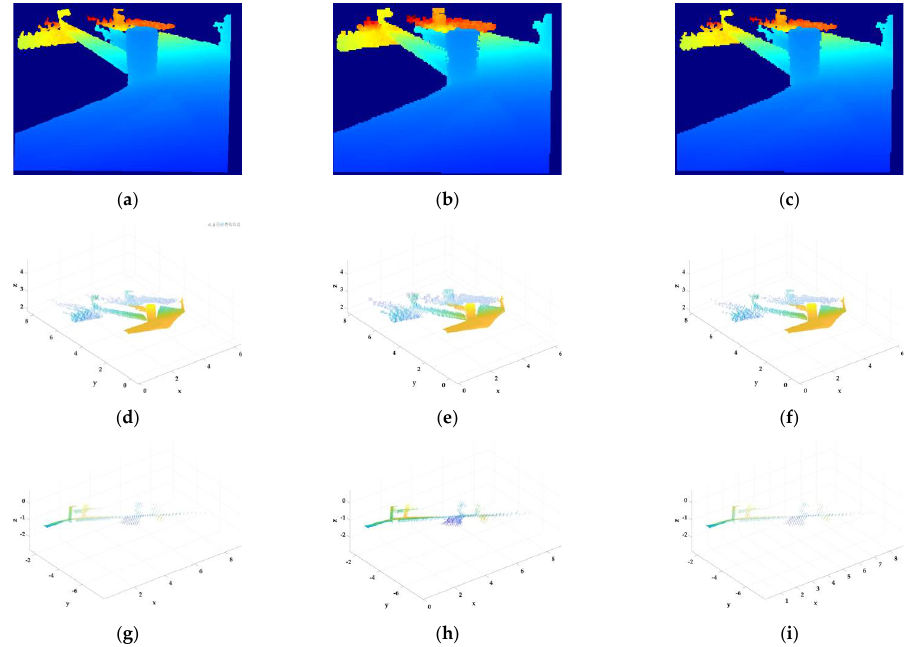
Figure 16. Validation of fractional-order differential Kriging interpolation super-resolution model (dataset no. 03528). ( a , d , g ) Original depth images; ( b , e , h ) Outputs of fractional-order differential Kriging interpolation super-resolution model ( ν = 0.6, PSNR = 33.677 dB); ( c , f , i ) Outputs of nearest- neighbour interpolation super-resolution model (PSNR = 25.825